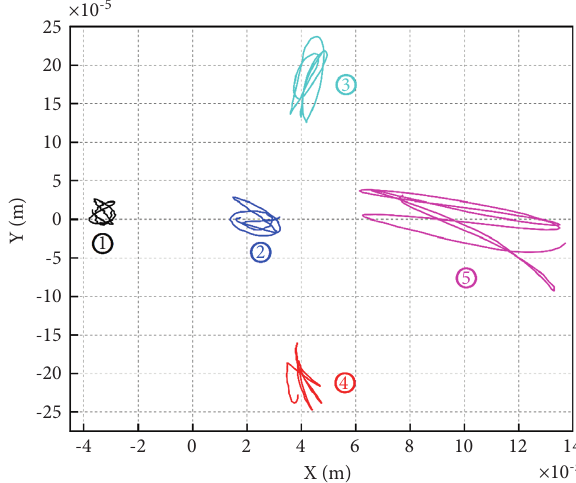
Figure 26: Vibration displacement curves of different tube bundles with the pitch-diameter ratio of 1.5.